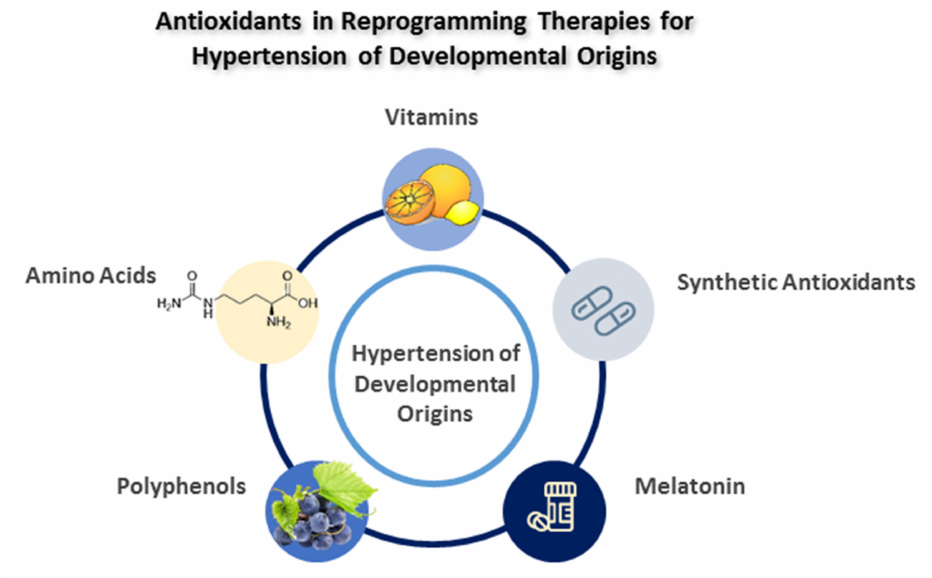
Figure 3. Schema outlining the potential antioxidants as a reprogramming strategy to prevent the hypertension of developmental